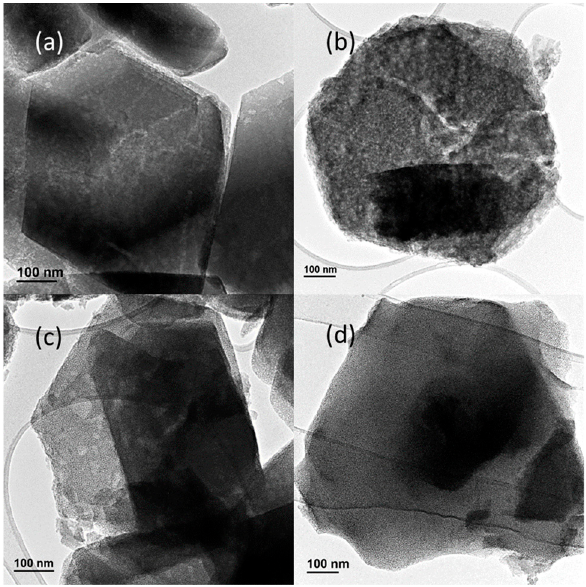
Figure 1. TEM images of the samples ( a ) H-Y, ( b ) H-USY-0, ( c ) H-USY-1, and ( d ) H-USY-2.